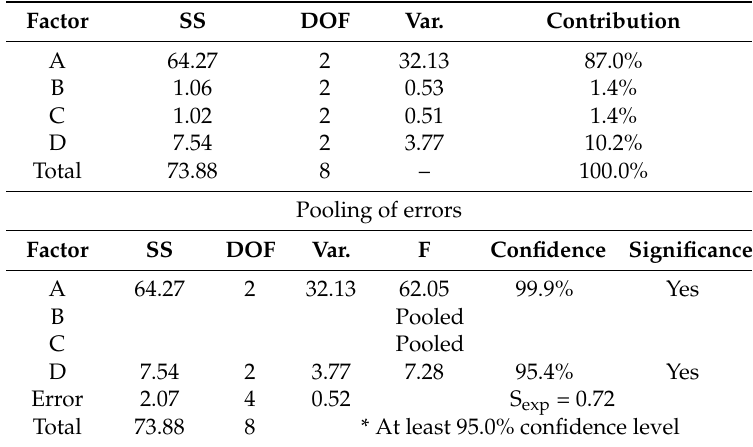
Table 6. Variance analysis table of signal-to-noise (S/N) ratio for tensile strength. Factor SS DOF Var. Contribution A 64.27